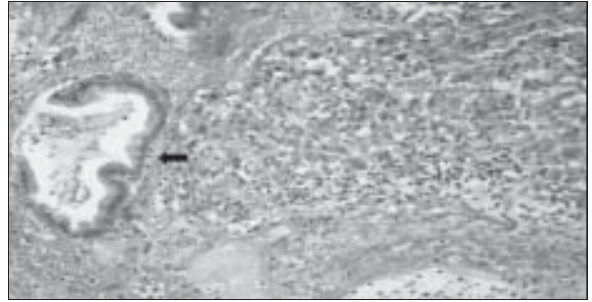
Figura 2A – Neoplasia maligna infiltrando as glândulas endocervicais (seta) (hematoxilina-eosina, 100x)